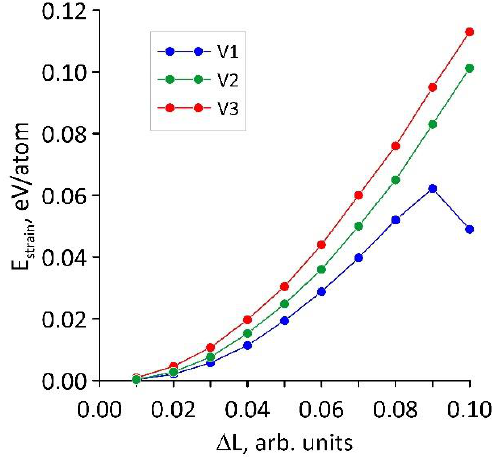
Figure 3. Graphs of the strain energy E strain on the strain value Δ L in relative units for three topological models (V1, V2, V3) of hybrid graphene/SWCNT (12, 6) films.